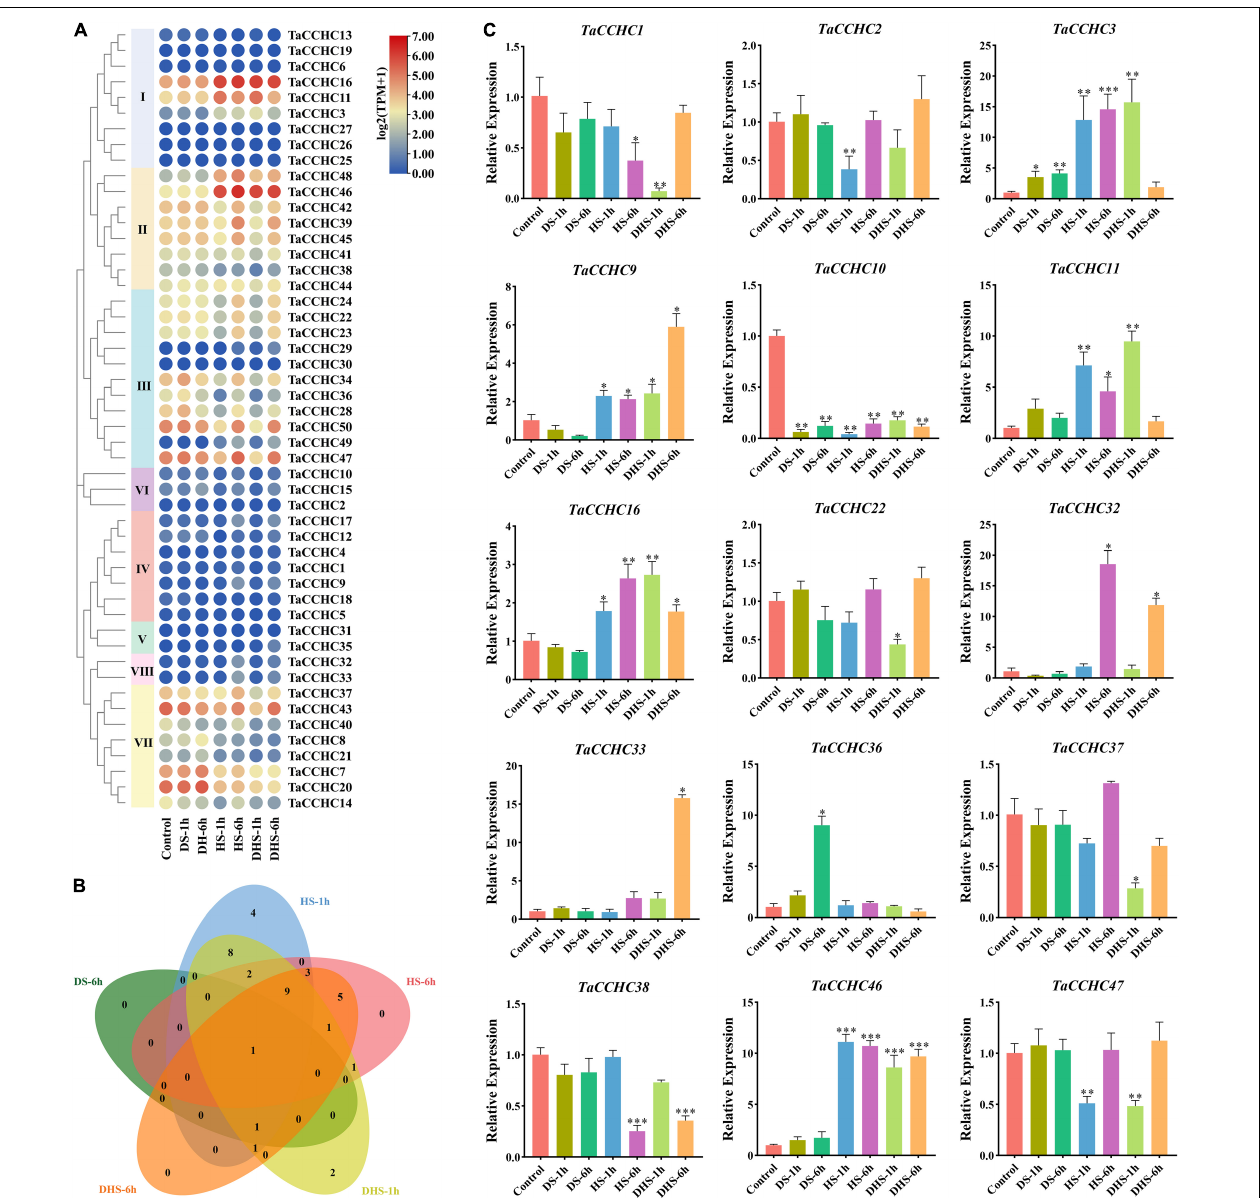
FIGURE 9 | Expression profiles of wheat CCHC-ZFP genes under different conditions. (A) Expression profiles of 50 TaCCHC-ZFP genes under different stress treatments. HS-1 (6) h: heat stress for 1 (6) h; DS-1 (6) h: drought stress for 1 (6) h; DHS-1 (6) h: combined drought and heat stress for 1 (6) h. The color in the heat map reflects TaCCHC-ZFP genes expression level. (B) Venn diagrams of DEGs under different treatments. (C) Expression analyses of 15 TaCCHC-ZFP genes in response to different treatments by qRT-PCR. Data were normalized to actin-TaRP15 and error bars represent standard deviation among three independent replicates ( ∗ P < 0.05, ∗∗ P < 0.01, ∗∗∗ P < 0.001, and Student’s t